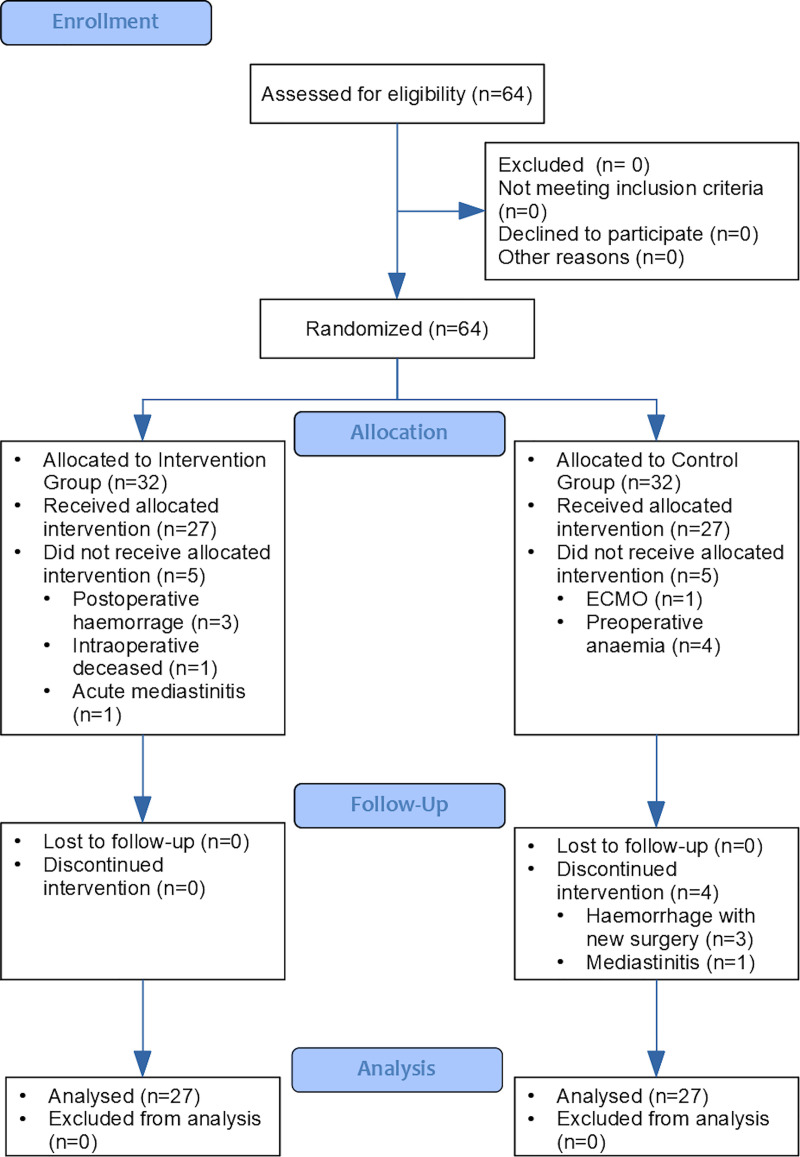
Study flow chart (CONSORT).